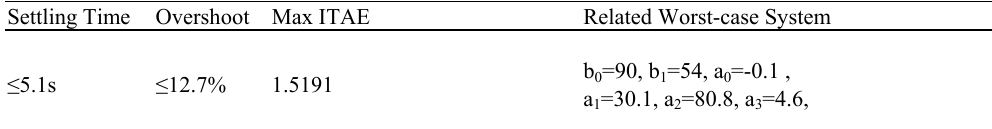
Fig. 5. The modified ITAE index of close-loop system with evolved controller is listed in Table. 2.